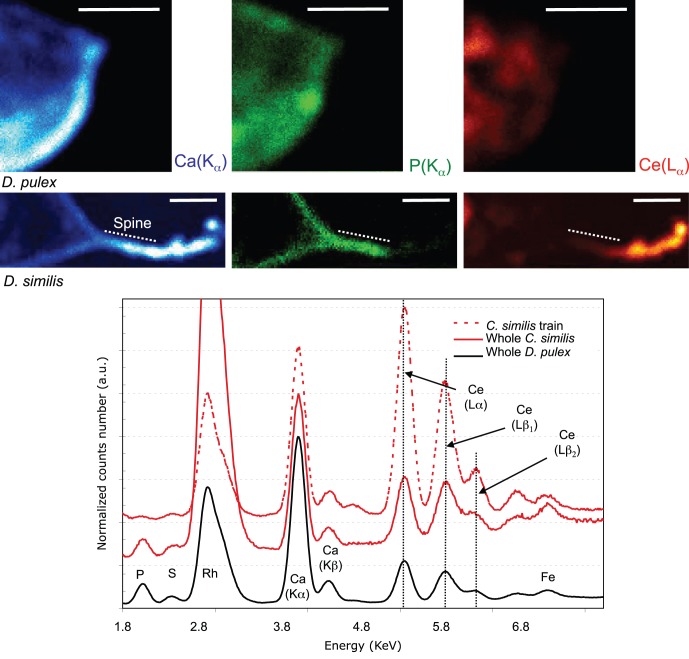
Distribution of Ce (Lα line), P (Kα line) and Ca (Kα line) on the posterior region of D. pulex and D. similis exposed 48 h to CeO2 NPs.Chemical map parameters: 128 pixel2 image, 1 pixel: 8 µm, total counting time 20000: sec, scale (white bar): 500 µm. Mean XRF spectra corresponding to specific area of the individual were generated from the hyperspectral map.